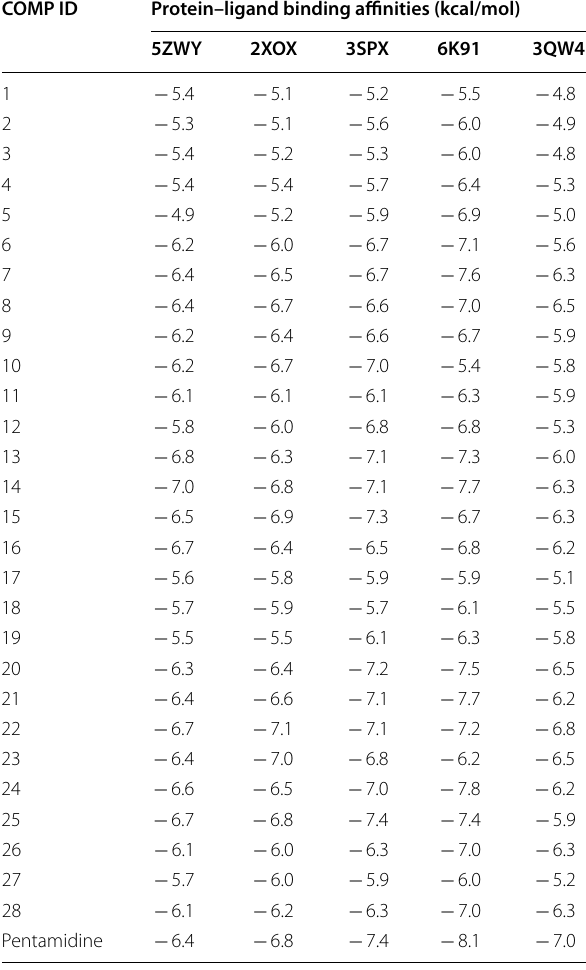
Table 9 Summary of binding affinities of interactions between maleimides and different L. donovani receptors used for the target fishing